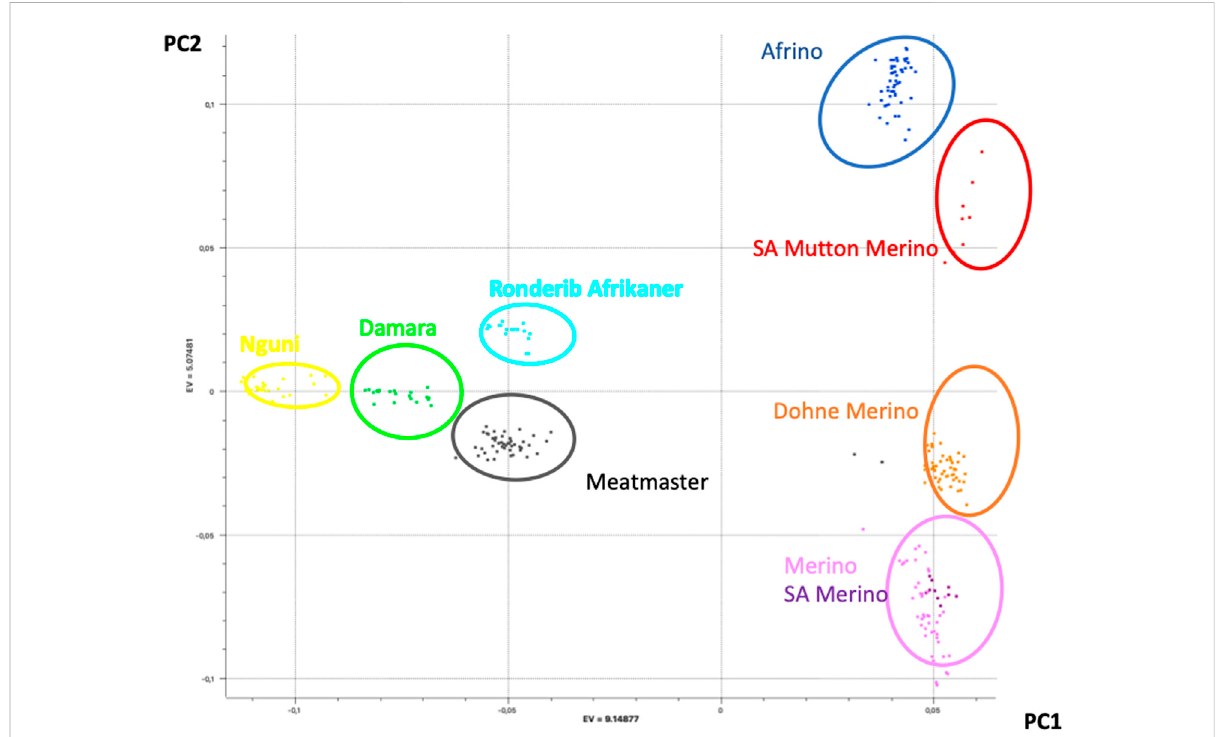
FIGURE 1 PCA-based clustering of Merino, Merino-derived breeds, and non-Merino presumed